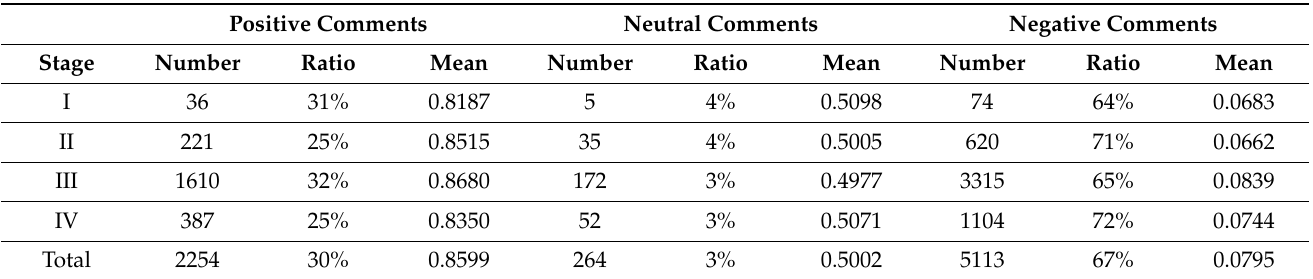
Table 3. Emotion classification and emotion value at each stage of public